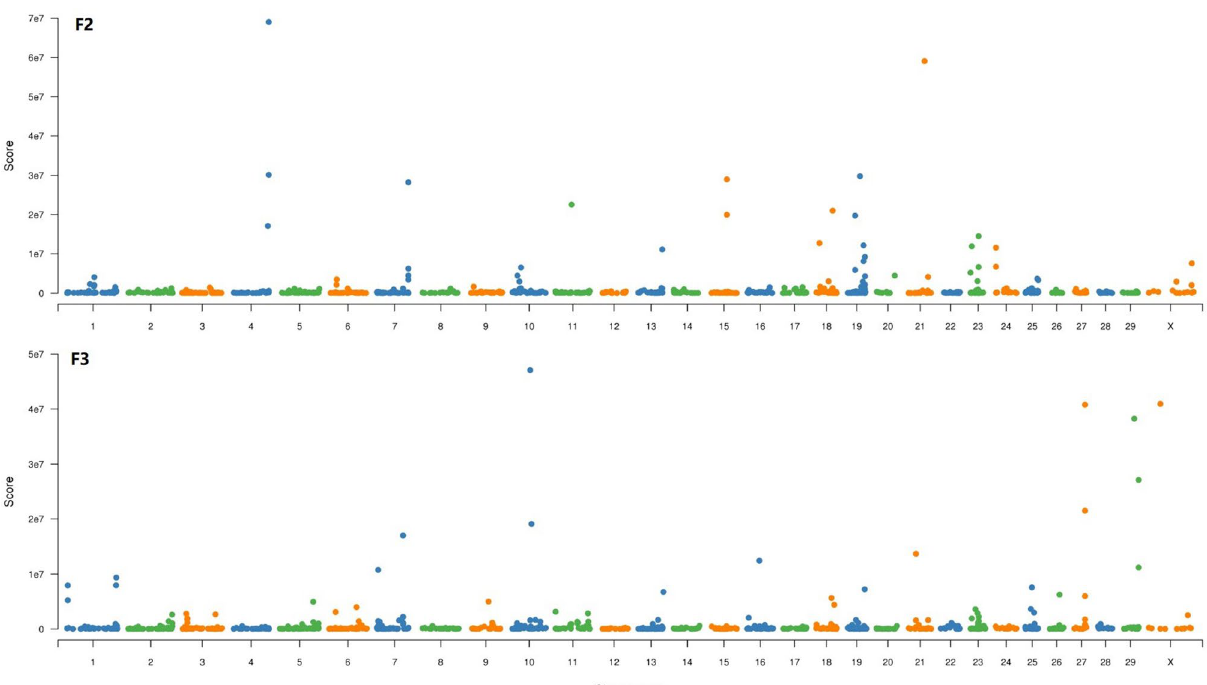
Figure 5. Variance analysis of allele frequency in 10 SNP slide